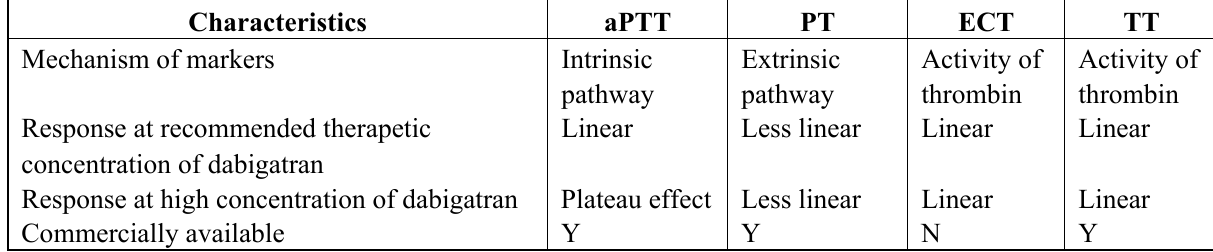
Table 2. Potentially useful test for the anticoagulant effect of dabigatran [27,55]. Characteristics aPTT PT ECT TT Mechanism of markers Intrinsic Extrinsic Activity of Activity of pathway pathway thrombin thrombin Linear Less linear Linear Linear Response at high concentration of dabigatran Plateau effect Less linear Linear